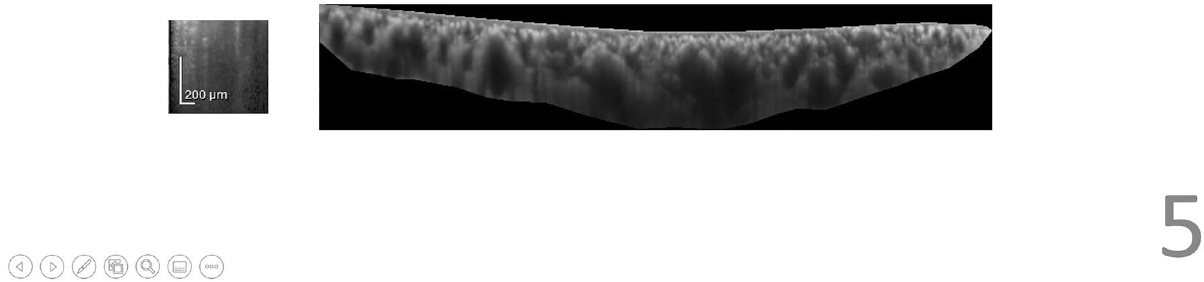
Figure 3. An example of isolated choroidal segmentation that was exported into a powerpoint slide for manual